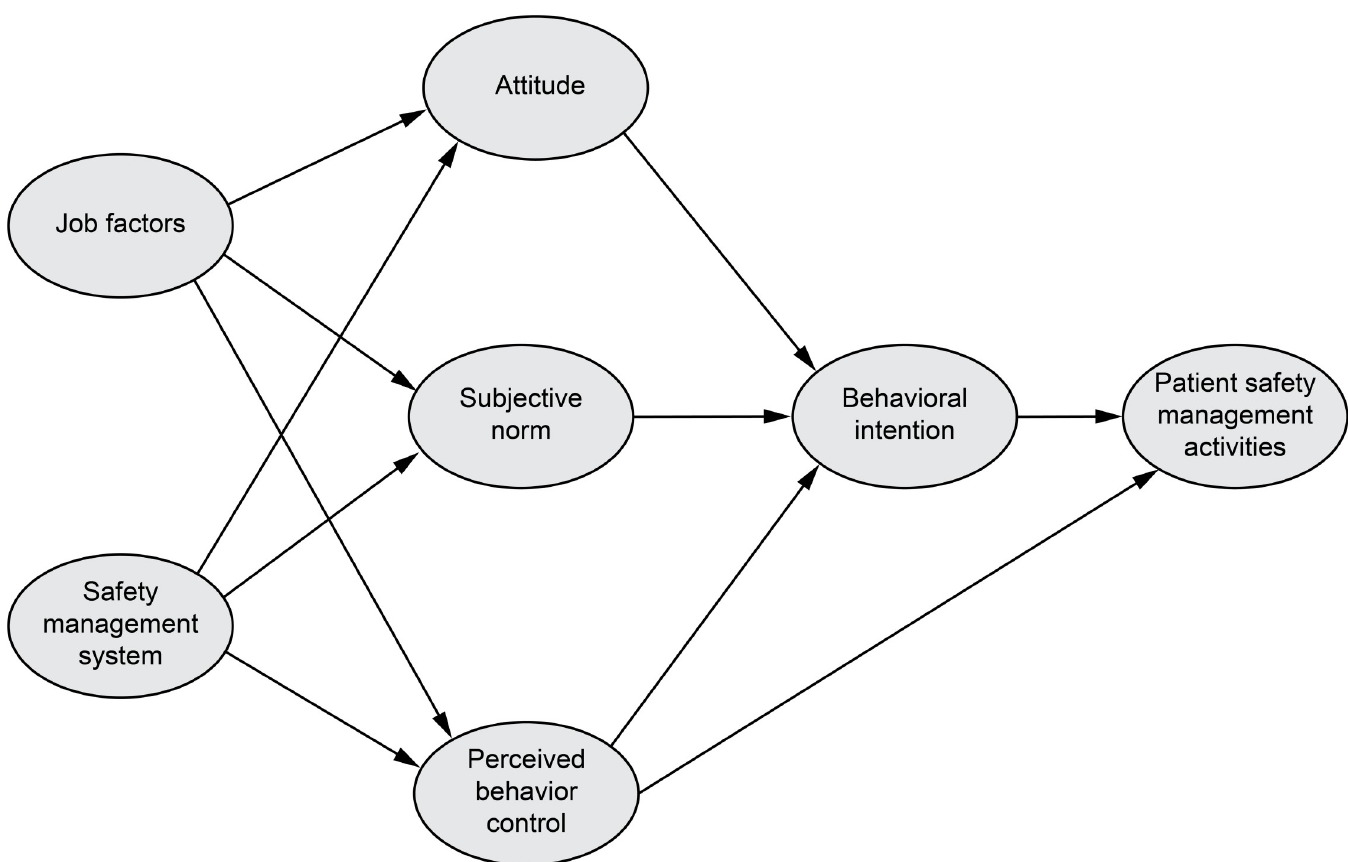
Fig 1. Conceptual